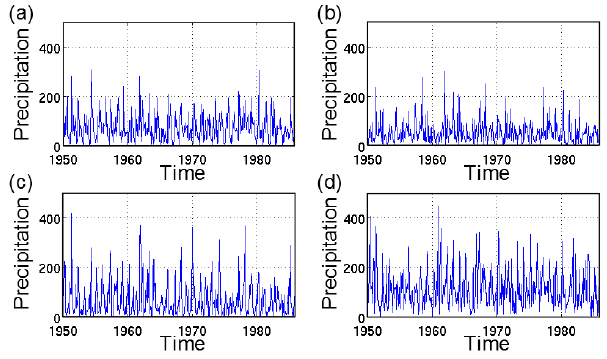
Fig. 3. Location of the used weather stations in Kenya. Nakuru (0 ◦ 17 0 S, 36 ◦ 4 0 E), Naivasha (0 ◦ 43 0 S, 36 ◦ 25 0 E), Narok (1 ◦ 5 0 S, 35 ◦ 52 0 E), and Kisumu (0 ◦ 6 0 S, 34 ◦ 45 0 E).